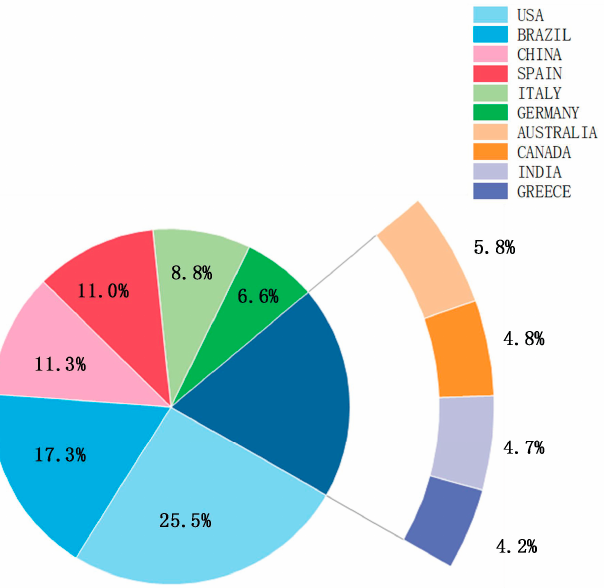
Figure 17. Contribution and influence of top 10 countries/regions in the field of precision